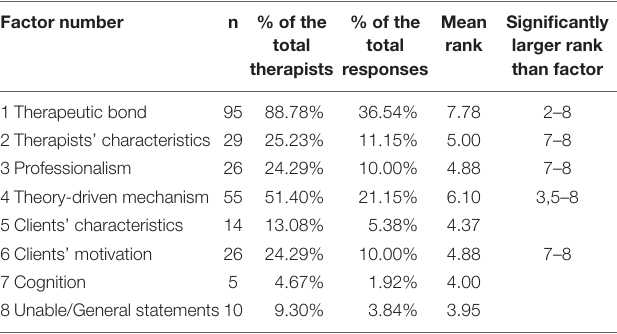
TABLE 3 | Percentages of responses within therapists and within total number of responses, mean ranks, and significance of differences in rankings. Factor number n % of the total